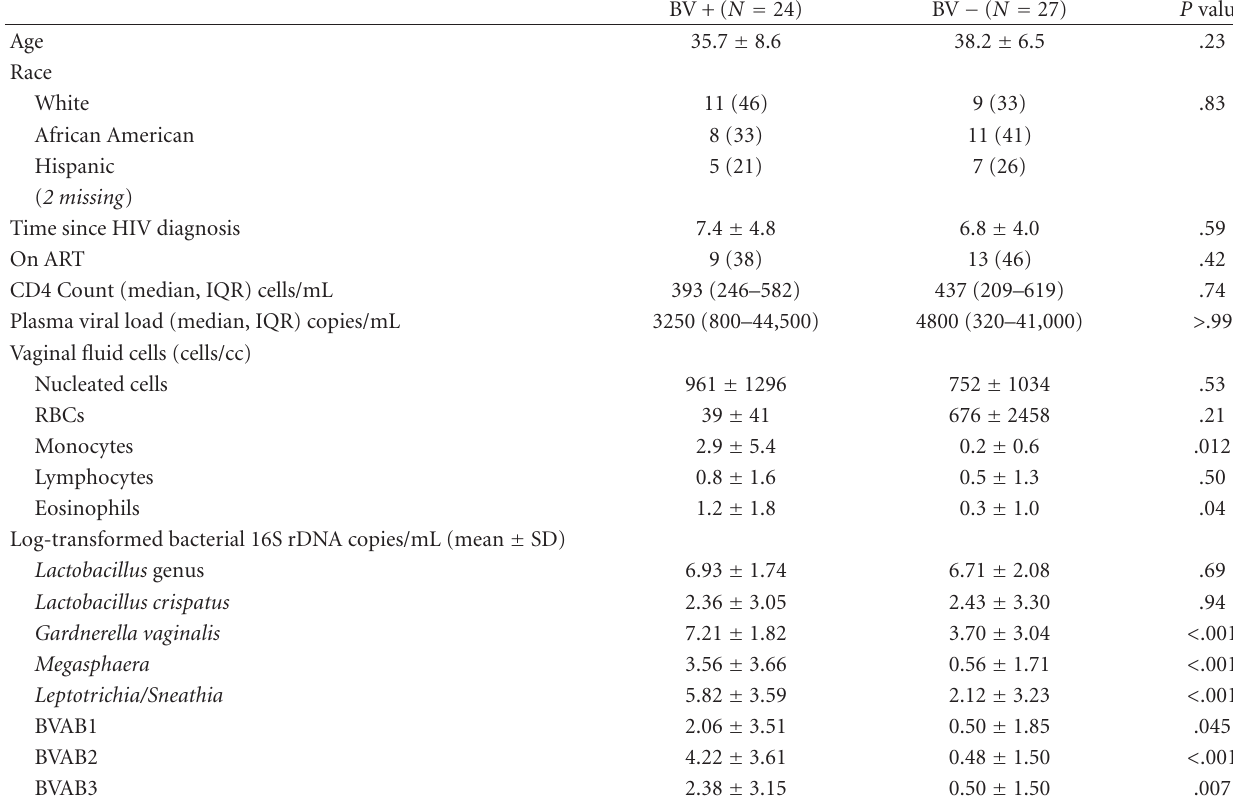
Table 1: Characteristics of the study population ( N = 51 §